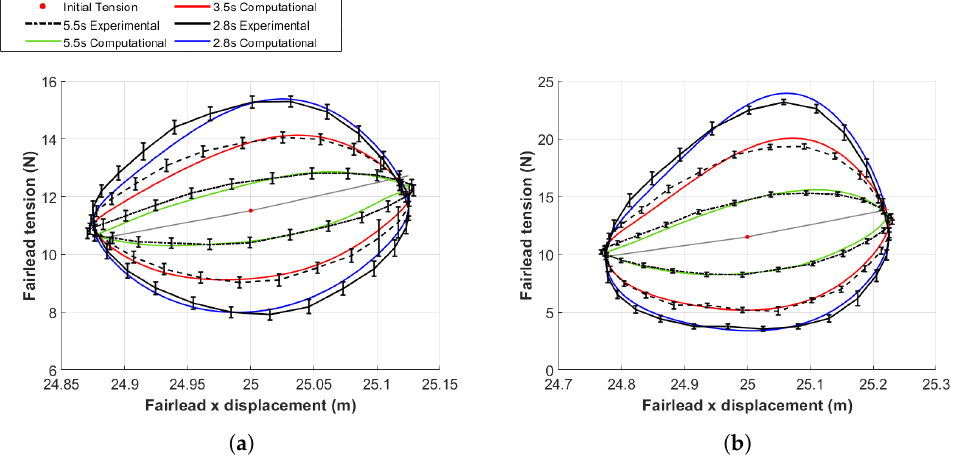
Figure 20. Comparison between the computed fairlead tension values and the experimental measure- ments of the isolated mooring line for two different oscillation amplitudes A = 0.125, 0.225 m and three different periods T = 2.8, 3.5, 5.5 s for the isolated mooring line. ( a ) A = 0.125 m. ( b ) A = 0.225